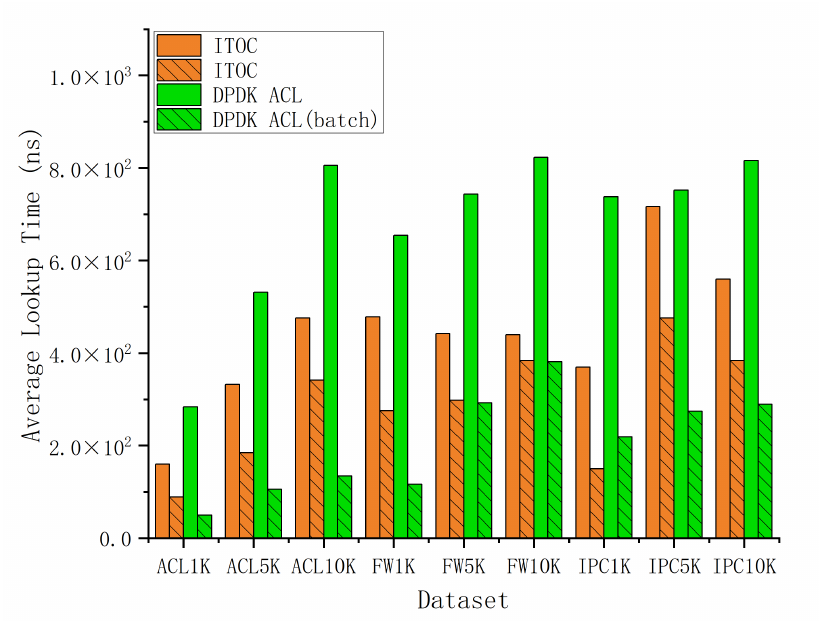
Figure 8. Average lookup time comparison.